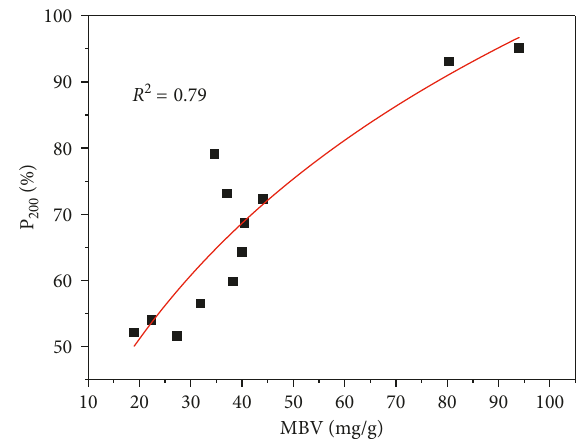
Figure 3: Correlation between MBV and P